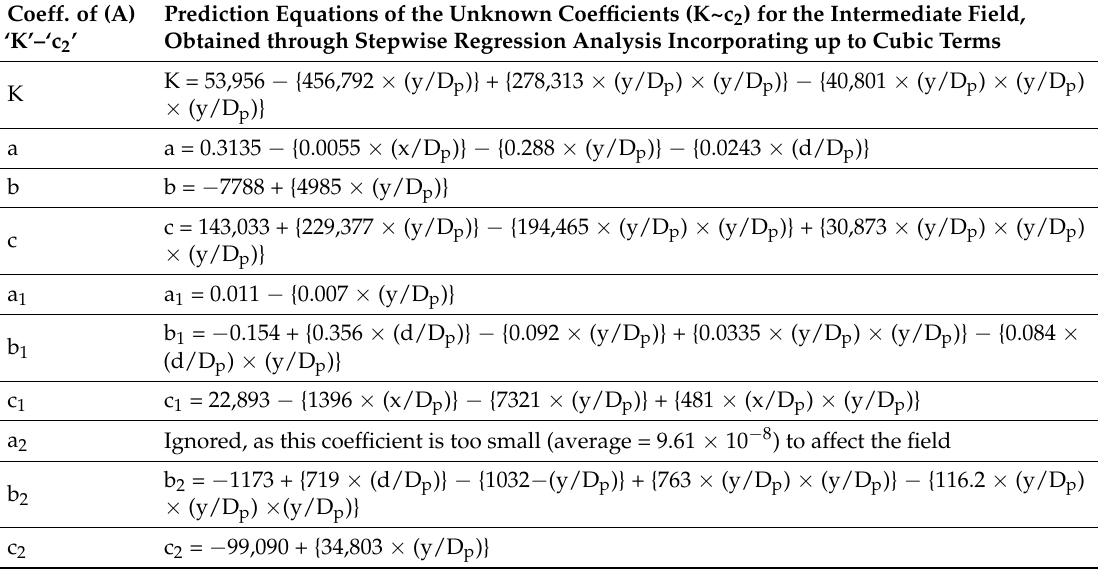
Table 5. Regression equations for predicting K, a, b, c, a 1 , b 1 , c 1 , a 2 , b 2 and c 2 for the Intermediate Field . Coeff. of (A) Prediction Equations of the Unknown Coefficients (K~c 2 ) for the Intermediate Field, ‘K’–‘c 2 ’ Obtained through Stepwise Regression Analysis Incorporating up to Cubic Terms